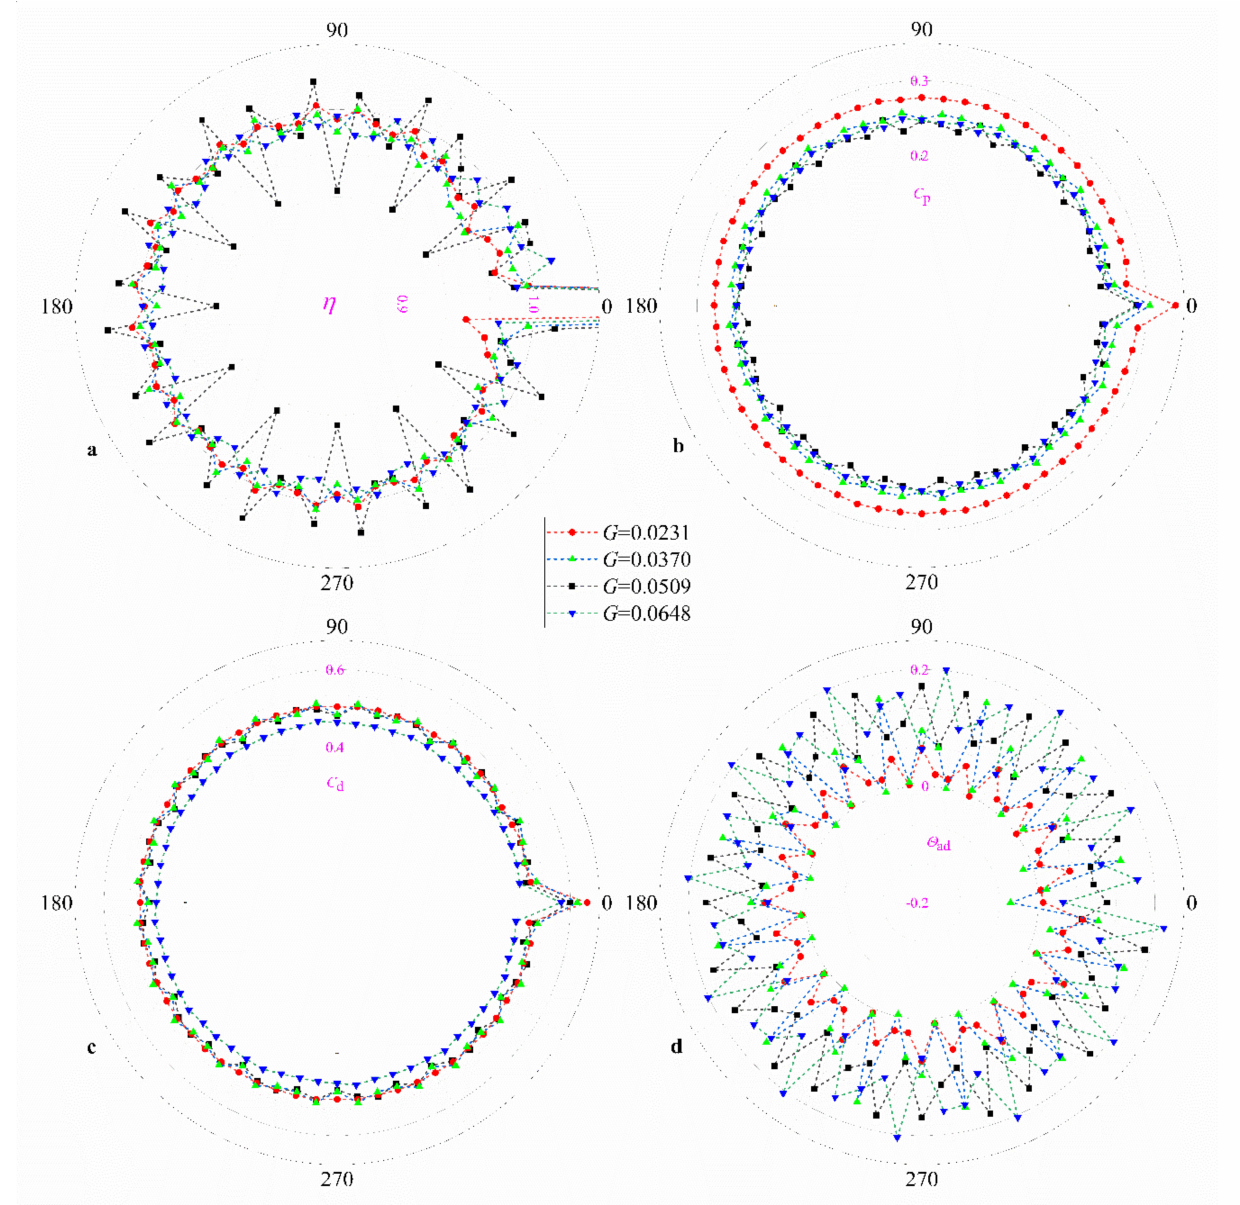
Figure 15. Distribution of ( a ) mass-flow-rate ratio η , ( b ) total-pressure-loss coefficient C p , ( c ) discharge coefficient of holes C d , and ( d ) adiabatic effectiveness Θ ad for different gap ratios